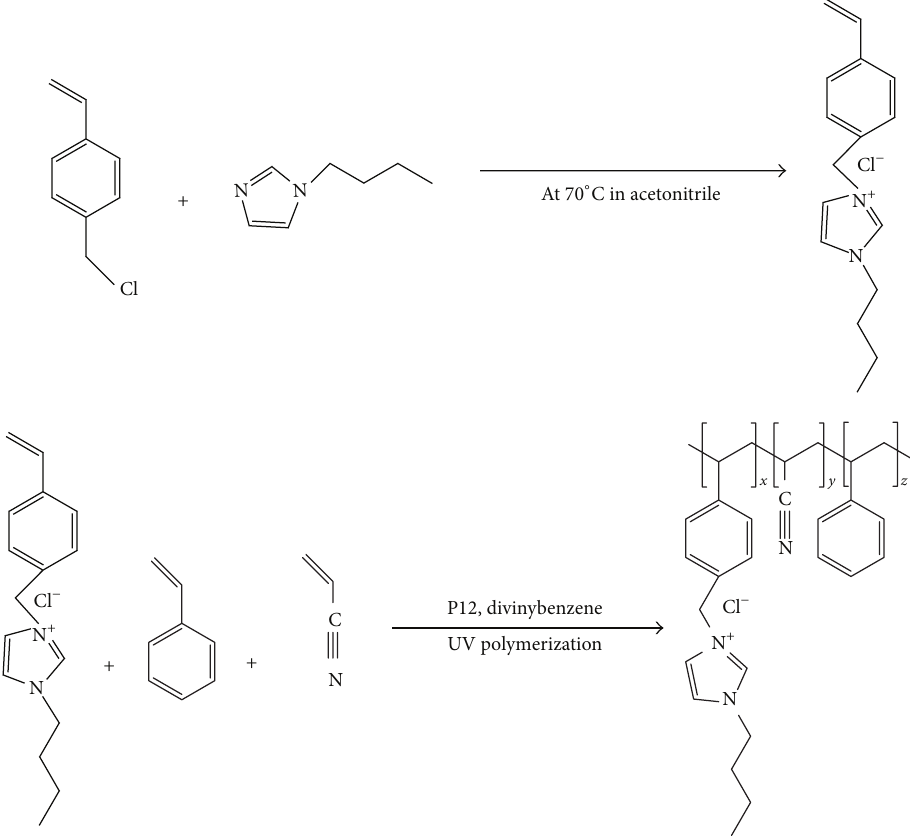
Figure 1: Synthesis of anion-exchange vinyl monomer and anion-exchange polymer by UV